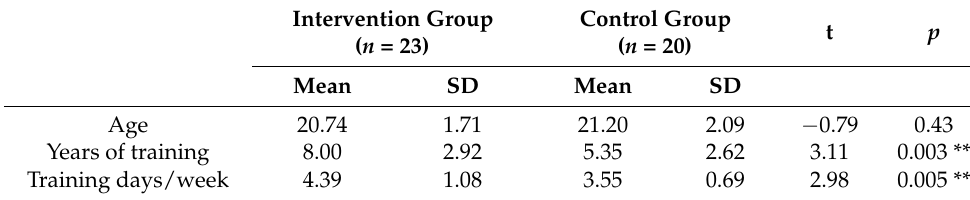
Table 2. Comparison of demographic information of the participants by group.